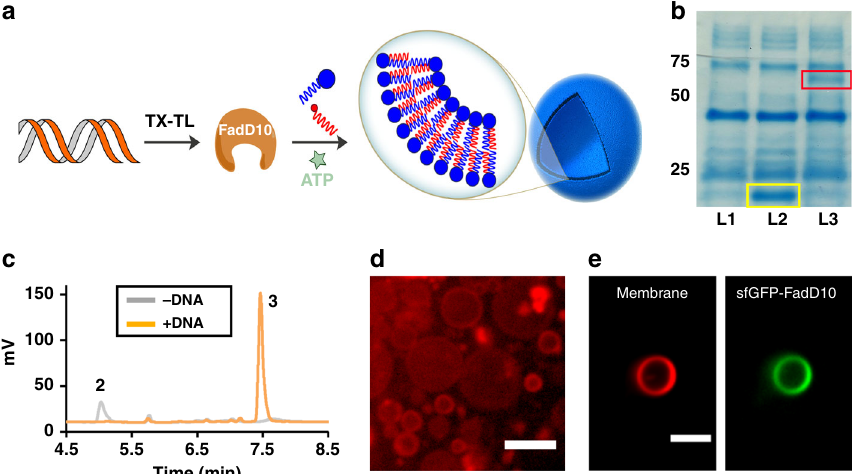
Fig. 4 Linking gene expression of FadD10 to phospholipid synthesis. a Schematic representation of the cell-free expression of FadD10 and subsequent assembly of the de novo synthesized phospholipid into vesicles in the presence of appropriate reactive precursors [TX-TL: transcription/translation]. b SDS – PAGE analysis of the expression of FadD10 in the PURExpress ® System. Lane L1: No DNA; Lane L2: DHFR DNA; Lane L3: FadD10 DNA. c HPLC/ ELSD traces monitoring the formation of phospholipid 3 by incubation of PURExpress ® System with an aqueous solution of dodecanoic acid, lysolipid 2 , ATP and MgCl 2 at 37 °C in the absence (gray line) or presence (orange line) of plasmid DNA coding for FadD10. d Spinning disk confocal microscopy of the in situ formed phospholipid vesicles in the PURExpress ® System driven by FadD10 expression. Membranes were stained using 0.1 mol% Texas Red ® DHPE dye. Scale bar: 5 µ m. e Localization of sfGFP-FadD10 to the membrane of the vesicles formed upon addition of the plasmid encoding the former into PURE system. External proteins were digested by Proteinase K. Scale bar: 5 µ